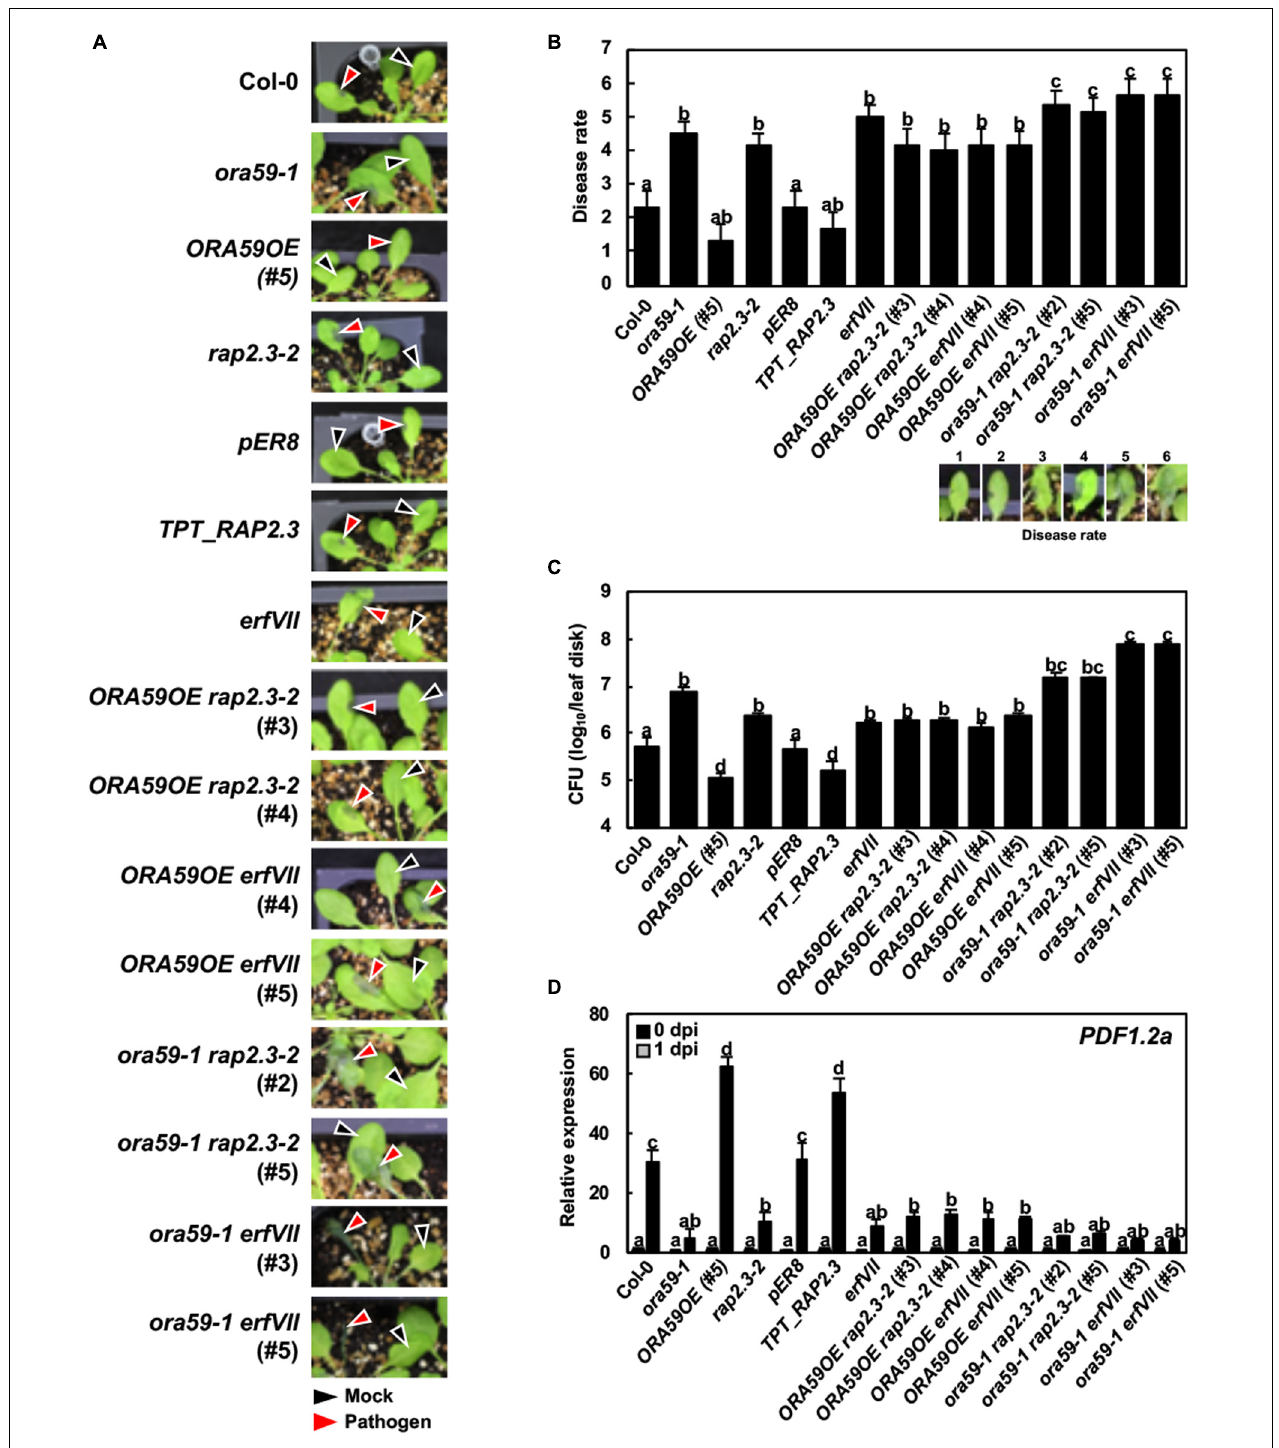
FIGURE 5 | Functions of ORA59 and RAP2.3 in resistance against P. carotovorum . (A) Disease symptoms in leaves inoculated with P. carotovorum . Inoculation sites are indicated by black arrowheads for 0.9% NaCl (mock) and red arrowheads for P. carotovorum . (B) Disease severity estimations (1–6) in leaves of (A) were made. The values are means ± SD ( n = 6). (C) Bacterial growth in leaves inoculated with P. carotovorum . The values are means ± SD ( n = 8). The experiment was repeated three times with similar results. (D) Expression of PDF1.2a in leaves inoculated with P. carotovorum . The values represent means ± SD from three independent experiments. Five-week-old plants were treated with 10 µ L of P. carotovorum at 10 5 cfu/mL (A,B) and 10 4 cfu/mL (C,D) for 1 day. Different letters indicate statistically significant difference (Tukey’s HSD test; P < 0.05).